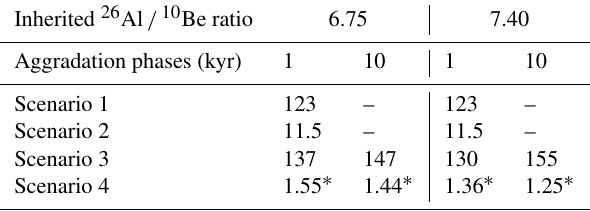
Table 3. Reduced χ 2 values of the optimal model fits for scenario 1, 2, 3 and 4, with 26 Al / 10 Be ratios of 6.75 and 7.40 and with 1 and 10kyr durations of the aggradation phases. The star indicates whether the p value did not show a significant disagreement be- tween observed and modelled CRN